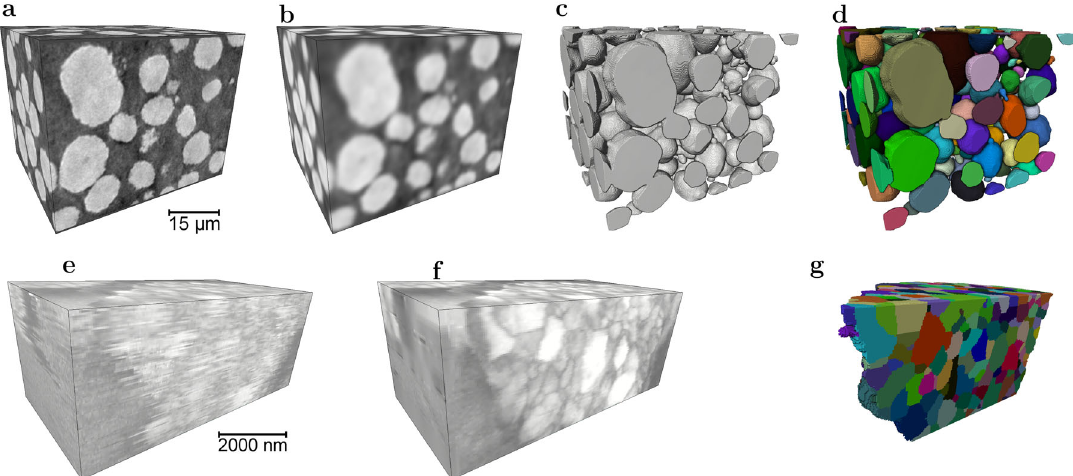
Fig. 2 Preprocessing of tomographic image data. Top row: Volumetric cutouts of raw ( a ), denoised ( b ), binarized ( c ), and segmented ( d ) CT data containing many full electrode particles. Figures a – d use the same length scale. Bottom row: Volumetric cutouts of raw ( e ), aligned ( f ), and segmented ( g ) FIB-EBSD data of a single particle showing morphological detail of numerous sub-particle grains. Figures e-g use the same length